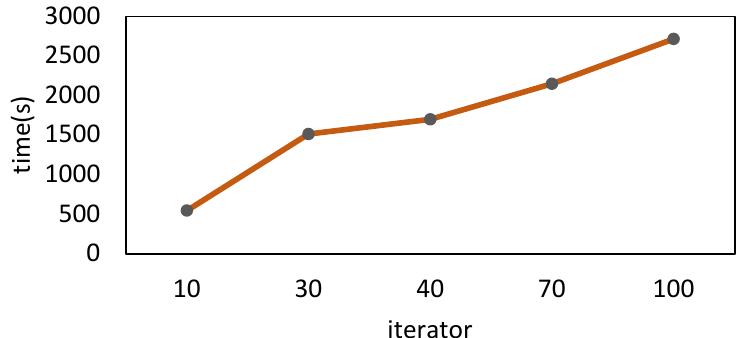
Figure 16. Comparison of different iterators on HomoCNN training time.